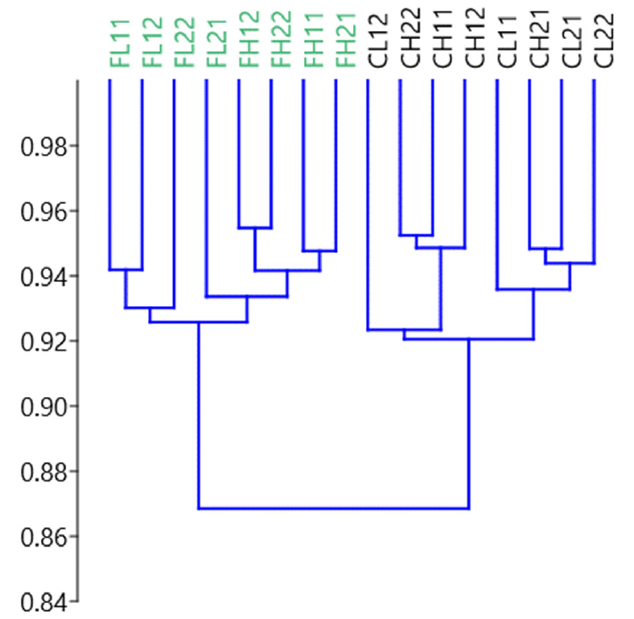
Figure 2. Dendrogram derived from a multivariate hierarchical cluster analysis, showing the grouping of the 16 RUSITEC fermenters according to diet (F = high forage or C = high concentrate) and pH (H = higher or L = lower). The number after the treatment code indicates the RUSITEC system and replicate number (there were two RUSITEC systems and two replicates of each treatment in each system). The y -axis represents the Bray-Curtis similarity measure.